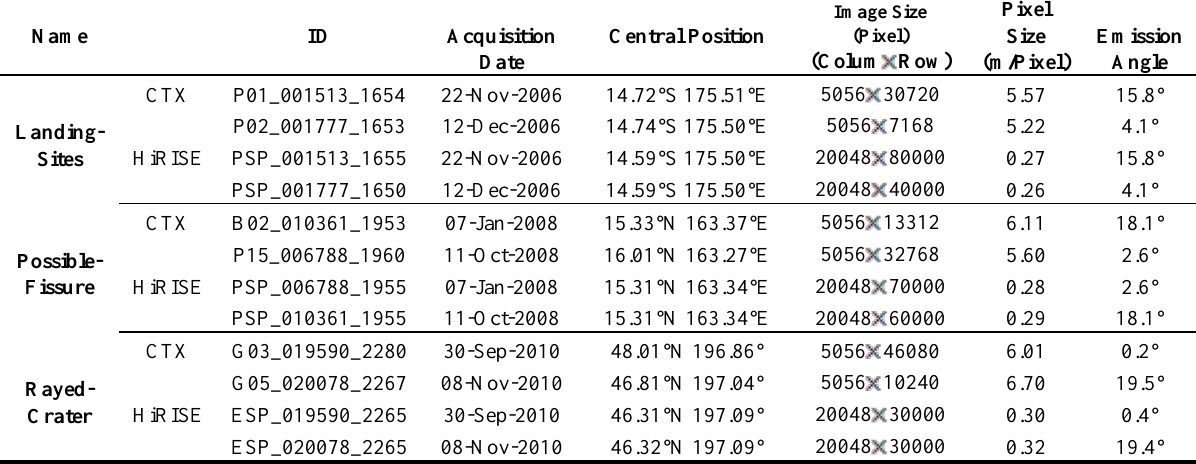
Table 1. Specifications of the CTX and HiRISE stereo images used in this research.